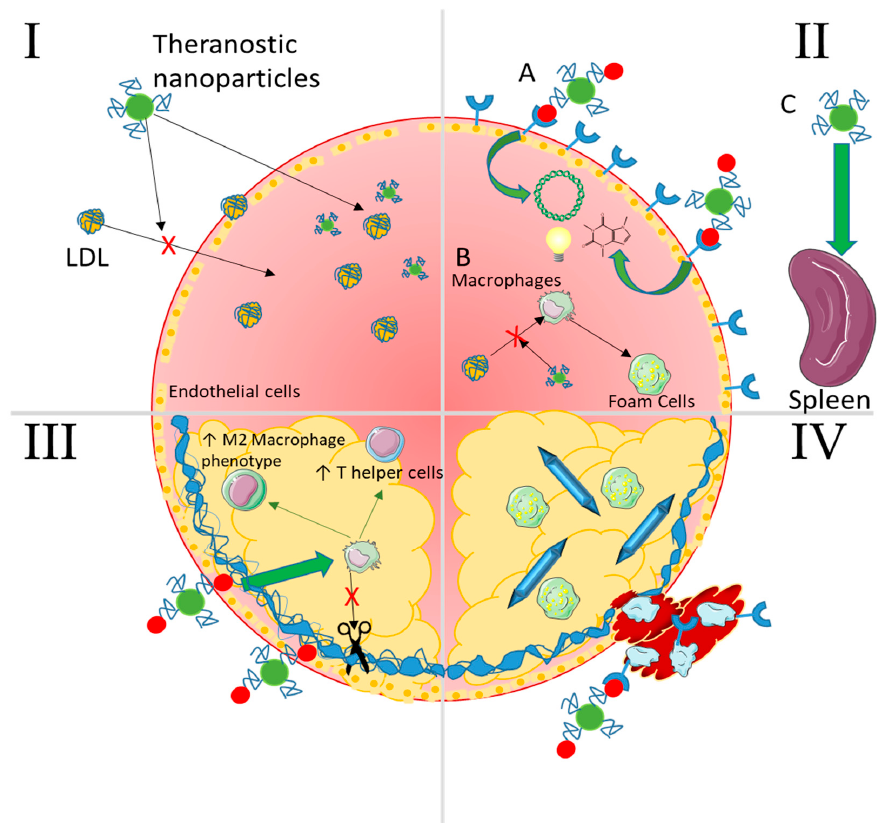
Figure 7. Summary of selected nanoparticle strategies capable of intervening at any stage of atherosclerosis. I—Lipid Accumulation NPs passively accumulate as well as lipids because of their size and surface functional chemistries and can even be made to mimic LDL. In addition, they can carry imaging contrast agents, drugs to lower cholesterol levels, and even nucleic acids to genetically regulate expression of cholesterol ester transfer proteins (CETPs). II—Non-resolving inflammation ( A ) NPs can target inflammatory recruitment receptors with conjugated moieties